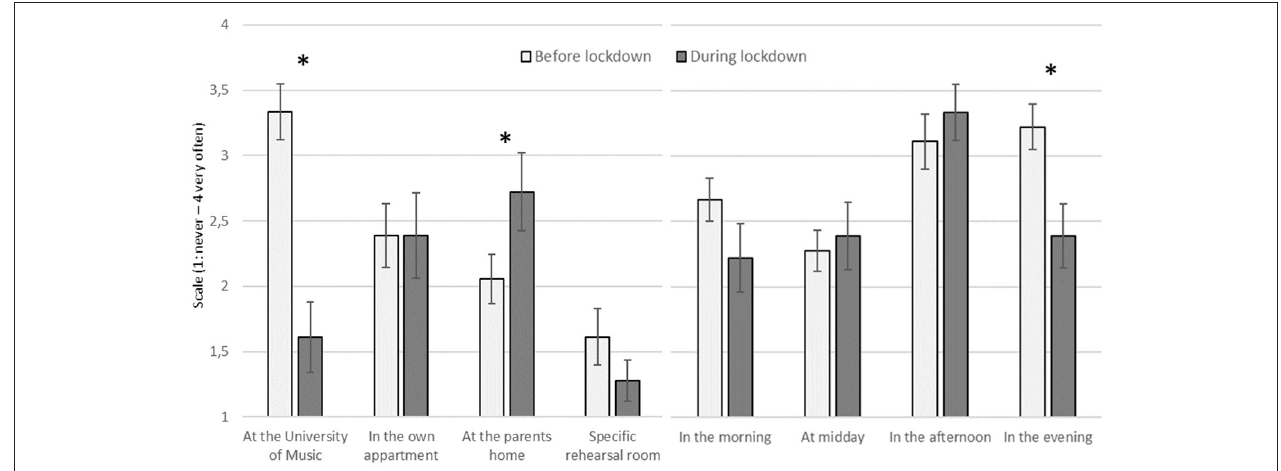
FIGURE 2 | Mean values of the questions where and when the music students practiced before and during the lockdown (error bar: standard error of the mean; * p < 0.05).